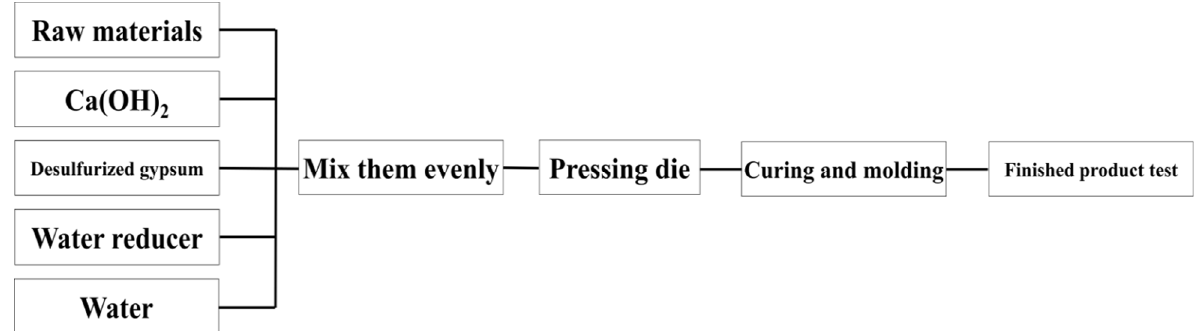
Figure 11. Flow chart of sample preparation of slurry test blocks.